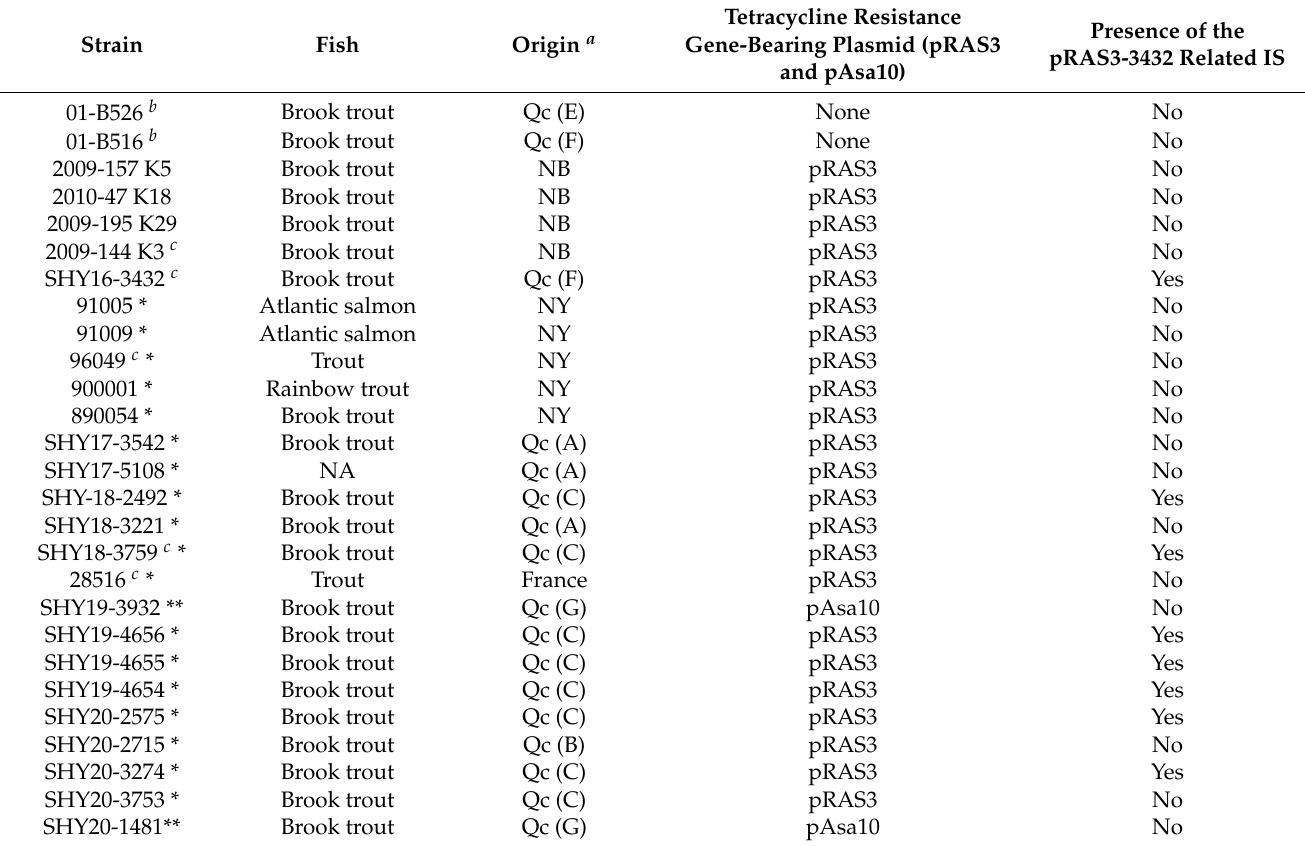
Table 1. Strains used in this study.